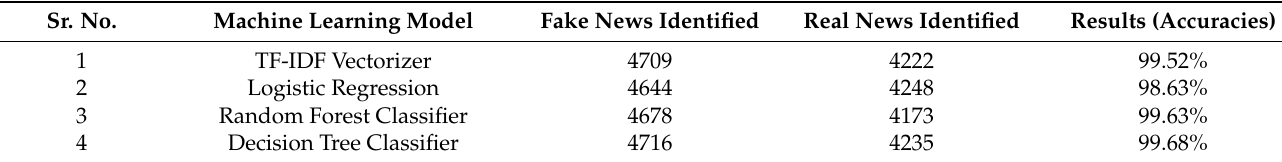
Table 4. Accuracies after applying machine learning models after cleaning.